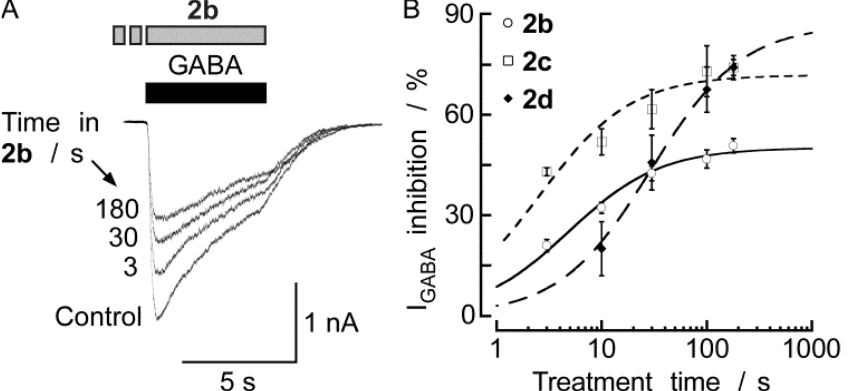
Figure 4. Halogenated DBTDs inhibited the I in a time-depended manner. ( A ) I GABA GABA was recorded before, during application of 100 μ M 2b , and after removal of the inhibitor of a given myenteric neuron for various lengths of time. The horizontal bars above the traces indicate the application profiles of the indicated substances. ( B ) Time course of I GABA (induced by 300 μ M GABA) inhibition induced by 2 over 3–180 s. Michaelis–Menten fits. Each data point represents the mean value from 3–12 different experiments. The lines represent the SEM.